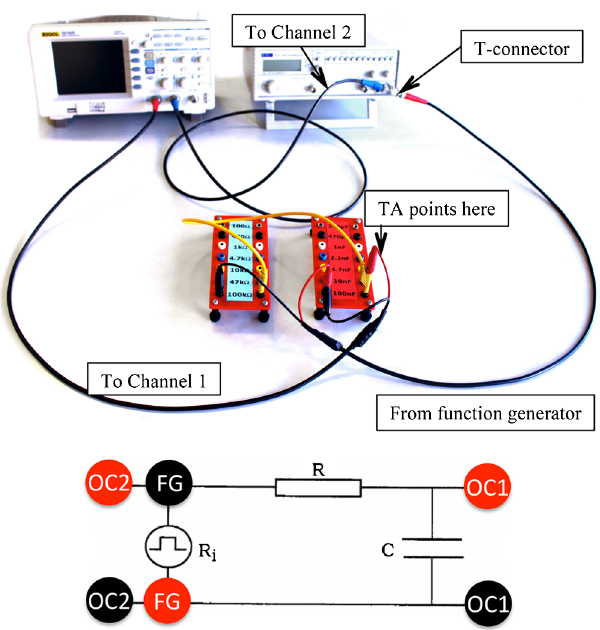
FIG. 7. A pictorial and a diagrammatic representation of the students ’ circuit after it had been corrected according to the TA ’ s advice. Both “ signal ends ” of the cables were then connected to the same (equivalent) point in the circuit. FG refers to the function generator and OC1 and OC2 refer to the oscilloscope ’ s channel 1 and channel 2,